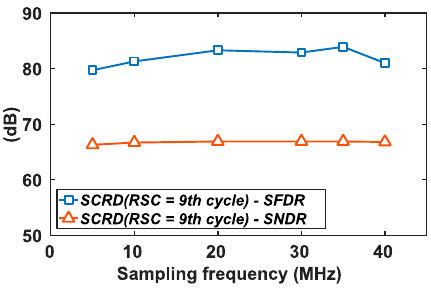
Figure 17. The measured dynamic performance of the SAR ADC with the SCRD according to the sampling frequency.